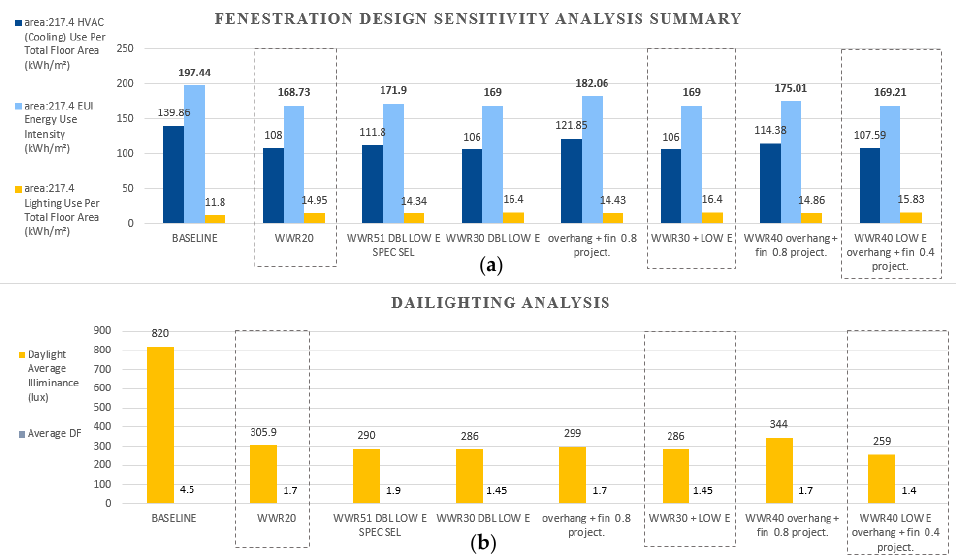
Figure 11. Summary of the highest performing results of WWR, glazing types, and external shading options in terms of the total building energy use ( a ) and daylighting levels ( b ) on the west façade (optimum performance highlighted in dotted box) .